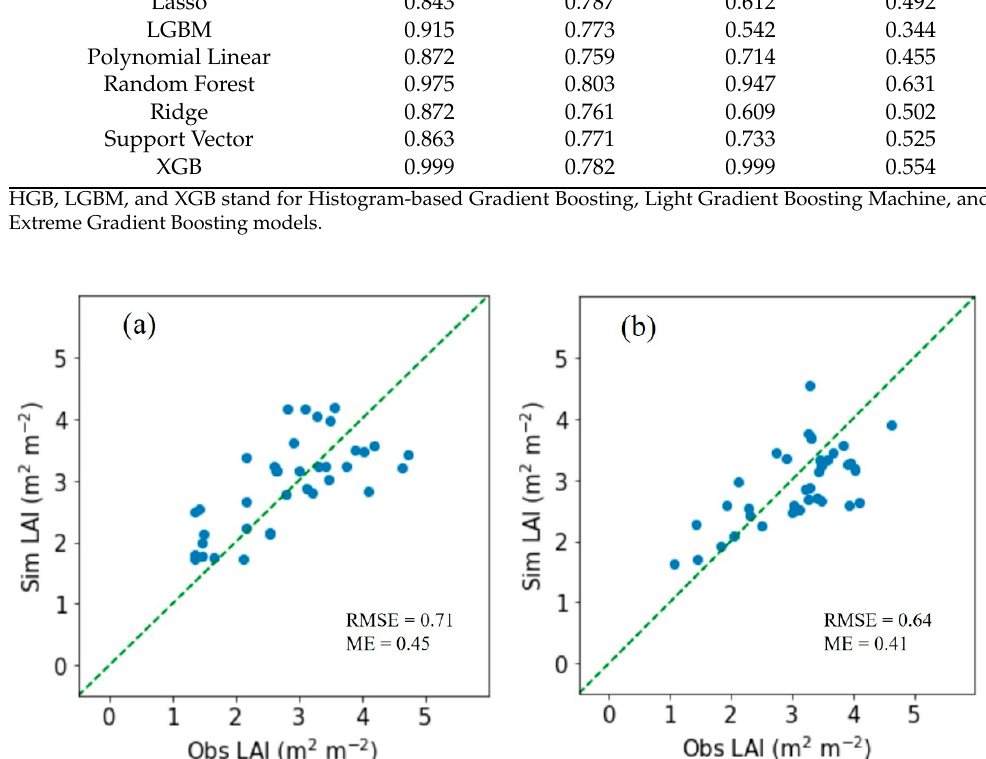
Figure 4. Comparisons between simulated (Sim) and observed (Obs) leaf area index (LAI) values for wheat by ( a ) Gradient Boost and ( b ) deep neural network regression models.